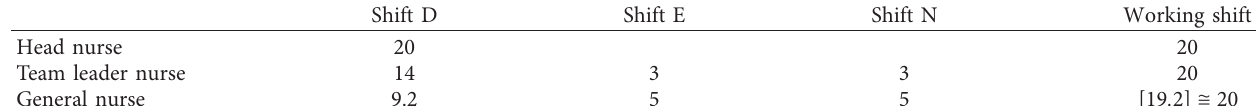
Table 7: A set of feasible shifts assignment for